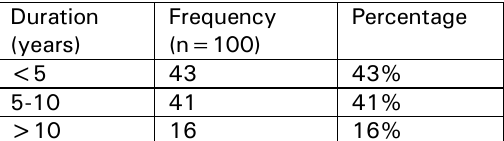
Table 2: Marriage Duration